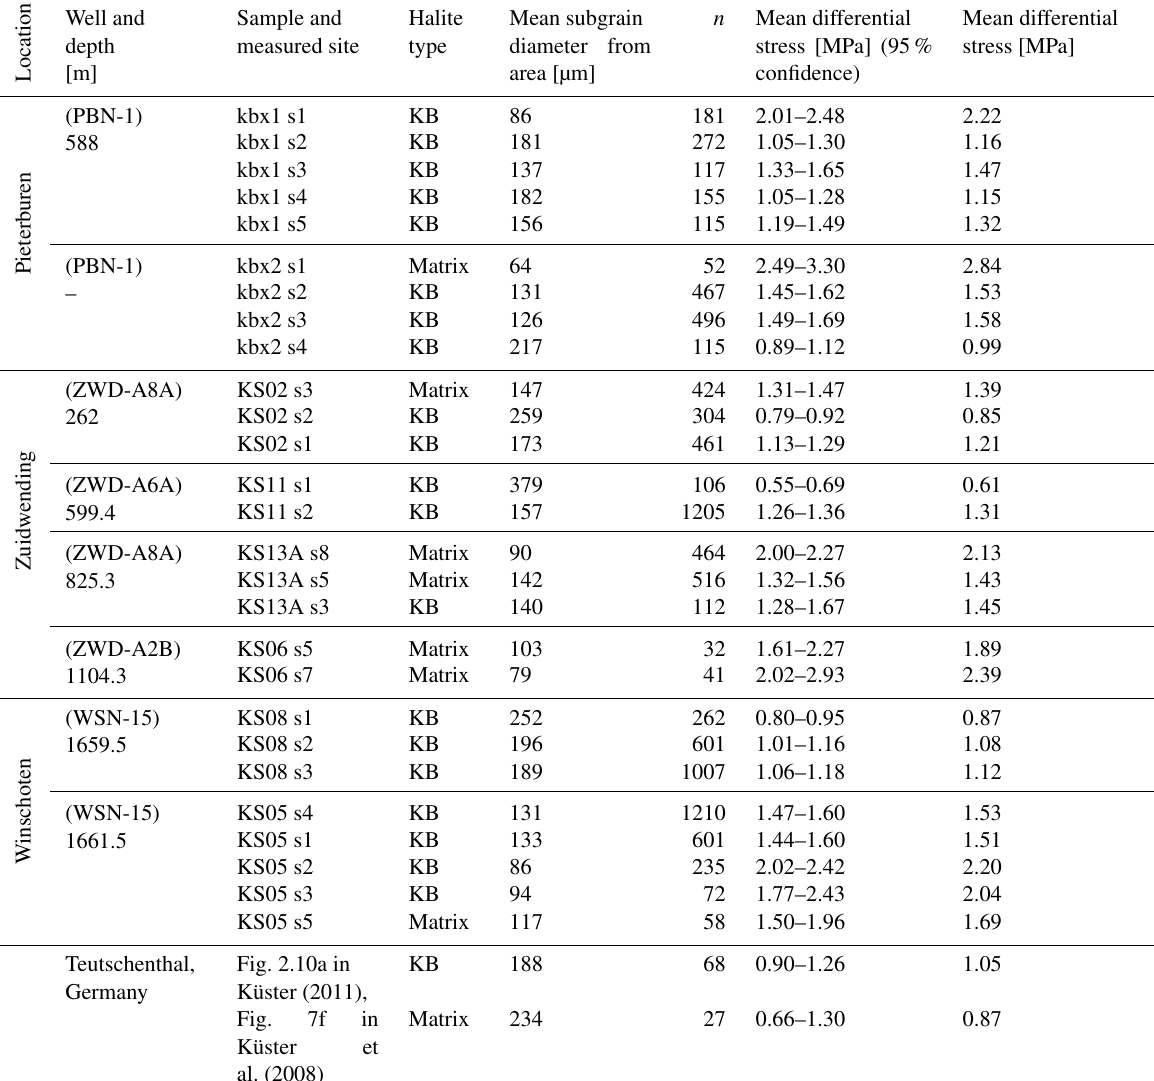
Mean differential stress [MPa]